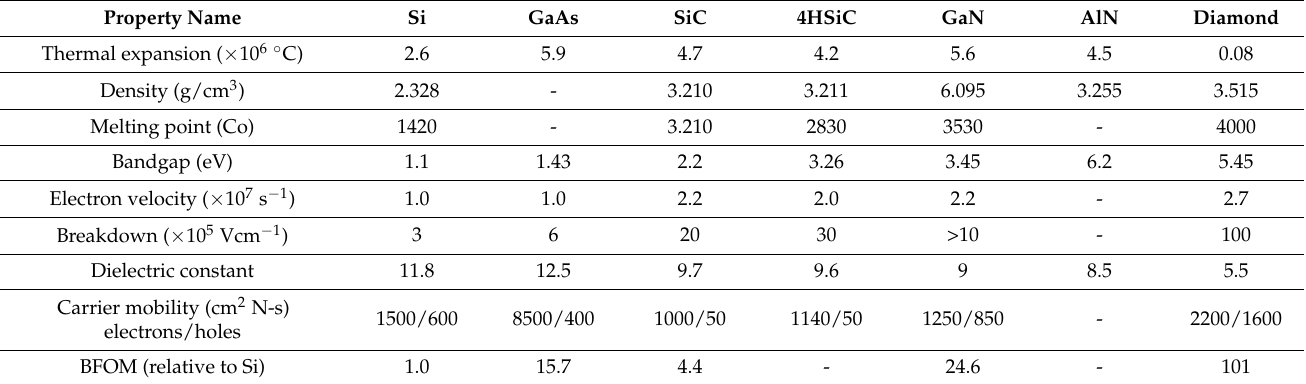
Table 1. Material properties of crucial semiconductor materials used in power